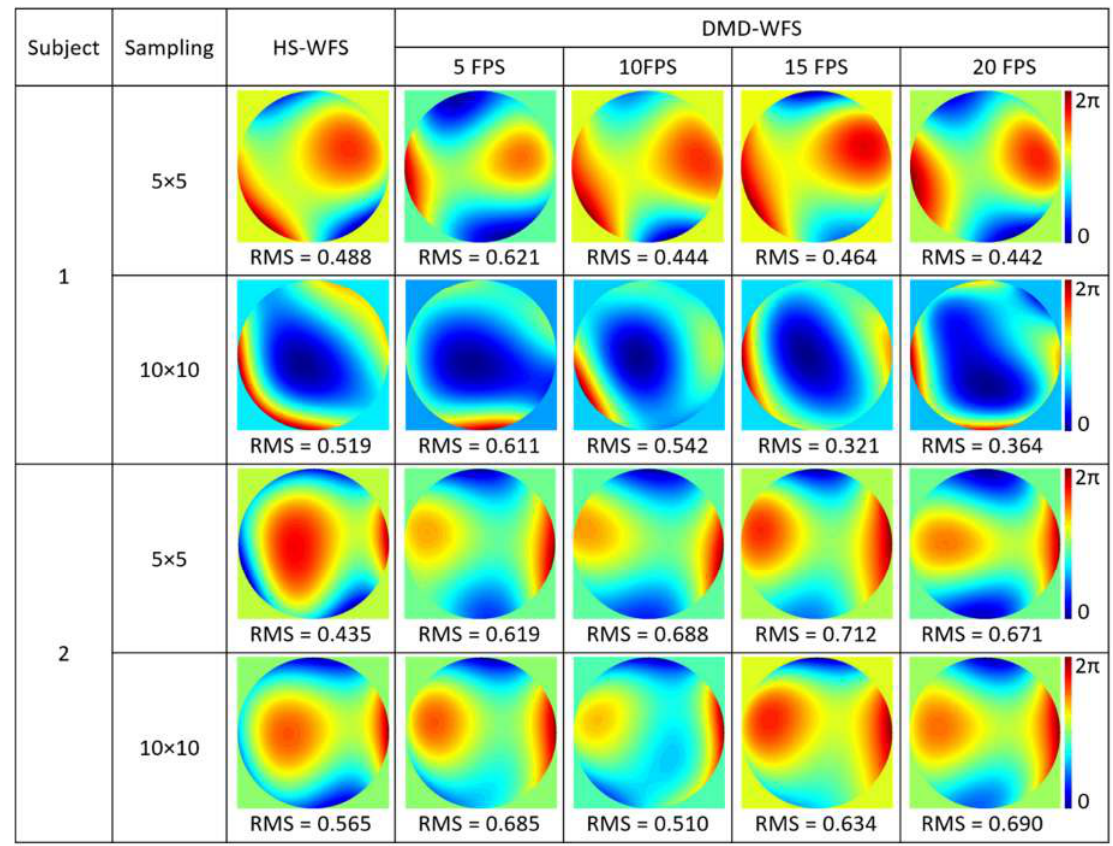
Figure 7. Comparison of the DMD-WFS scan performed at 5, 10, 15 and 20 FPS for two subjects with both 5 × 5 and 10 × 10 DMD cell sampling densities. All RMS values are given in μm.